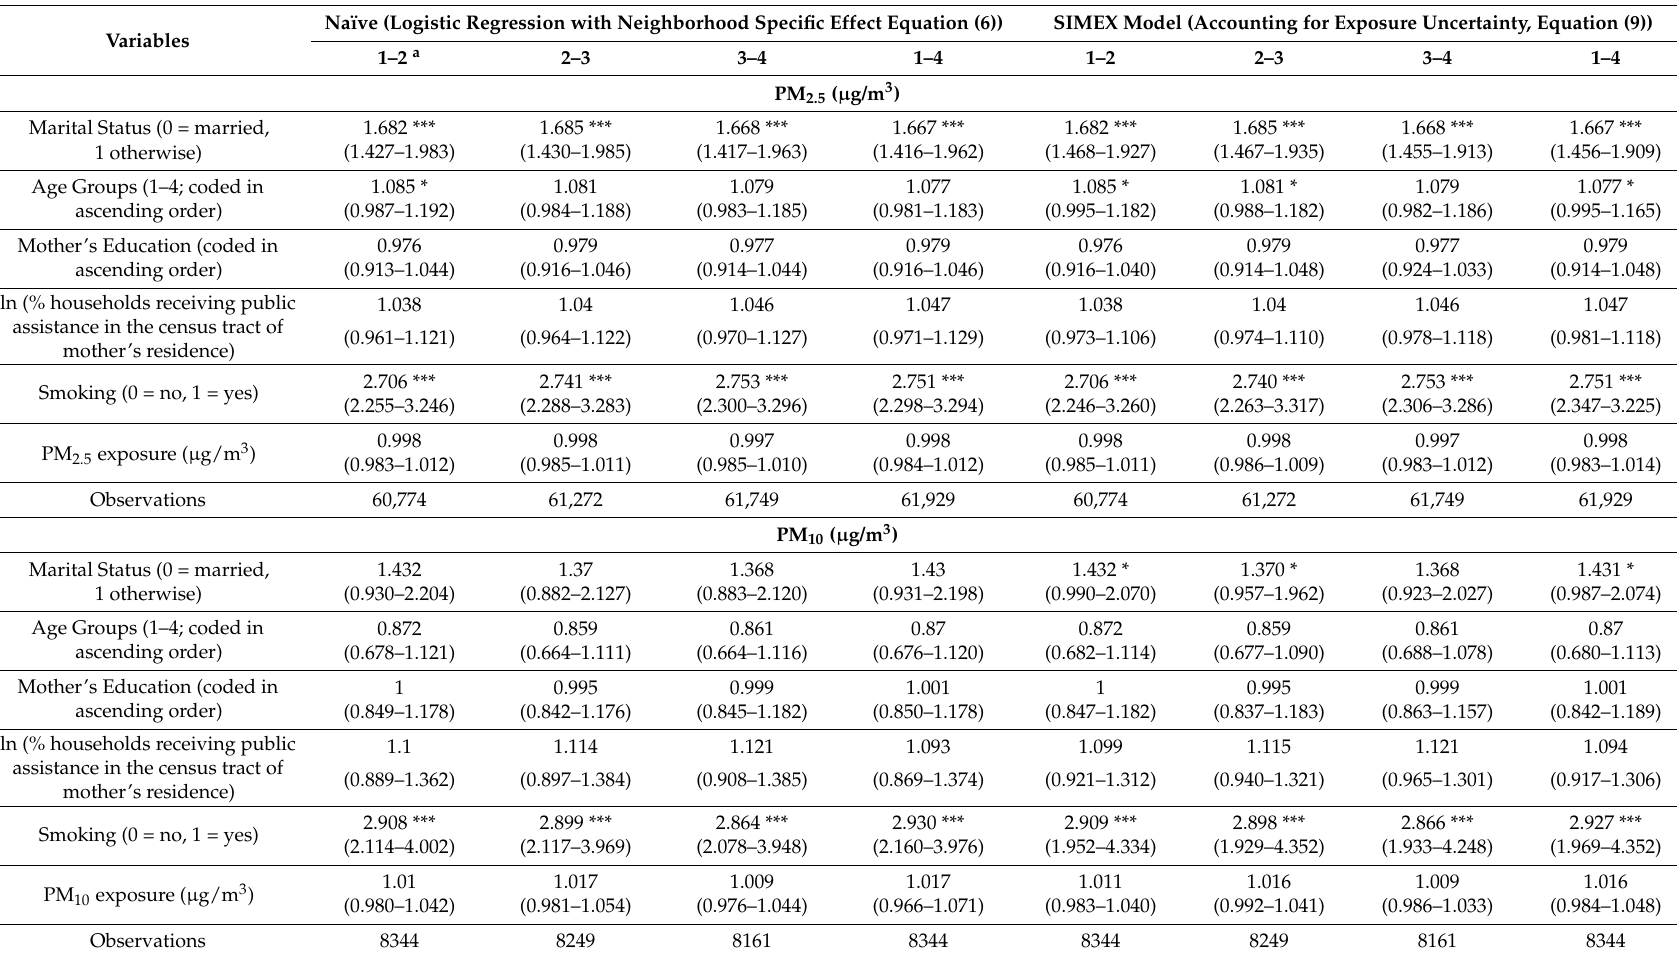
Table 5. Logistic regression of LBW (binary variable) with respect to PM exposure in Chicago, 2000–2004 without and with the exposure measurement error.